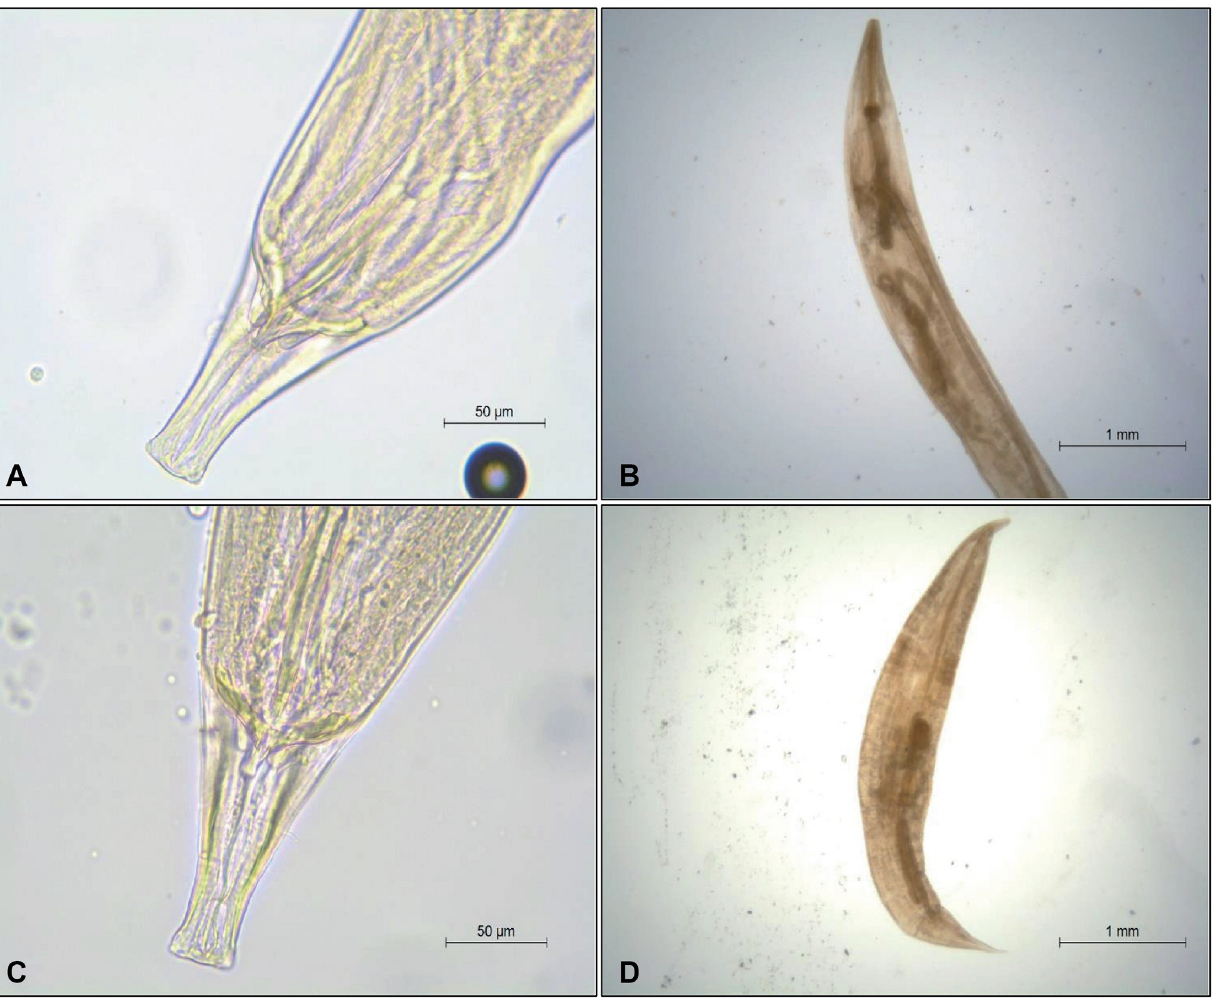
Fig 2. Ventral views of Tachigonetria nematodes identified from Chioninia coctei ’s digestive contents (photos by V. Roca). A) T . longicollis , male caudal end (only T . l . longicollis is represented as differences between subspecies are difficult to depict); B) T . numidica , female; C) T . macrolaimus , male caudal end; D) T . conica ,